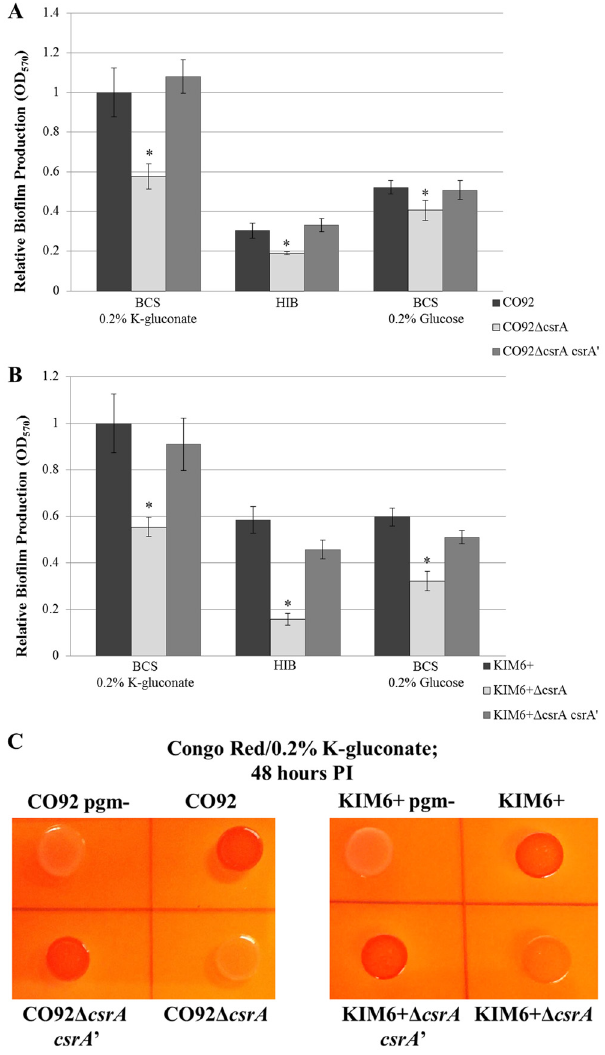
Fig 7. CsrA is a Positive Regulator of Y . pestis Biofilm Production. Relative biofilm production of the csrA -deficient mutants after 24 hours inoculation of BCS medium supplemented with 0.2% K-gluconate, HIB medium, or BCS medium supplemented with 0.2% glucose. (A) CO92, CO92 Δ csrA , and the chromosomal restoration mutant CO92 Δ csrA csrA ’ . (B) KIM6+, KIM6+ Δ csrA , and the chromosomal restoration mutant KIM6+ Δ csrA csrA ’ . Results reflect the average of two independently derived csrA -deficient mutants (CO92 clones 5a and 3b, and KIM6+ clones 2:14 and 4:12). Two biological replicates were assessed per mutant, each consisting of 6 technical replicates. Error bars reflect standard deviation from the mean among biological replicates. * P-value < 0.005 as determined by Tukey ’ s HSD post-hoc analysis. (C) Impaired Congo red assimilation of the Y . pestis csrA -deficient mutants. Phenotypic evaluation of Congo red binding of the CO92 and KIM6+ csrA -deficient mutants, chromosomal csrA restoration mutants, parental isogenic controls, and pigmentation locus negative (biofilm-deficient) mutants after 48 hours post-inoculation of Congo red plates supplemented with 0.2% K-gluconate.